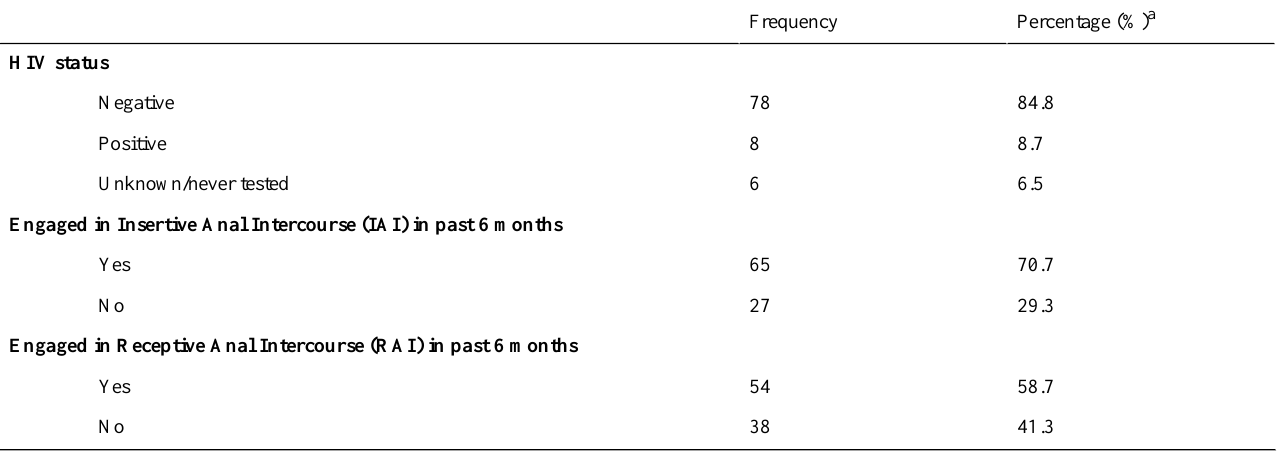
Table 3. HIV status and recent sexual behaviors.